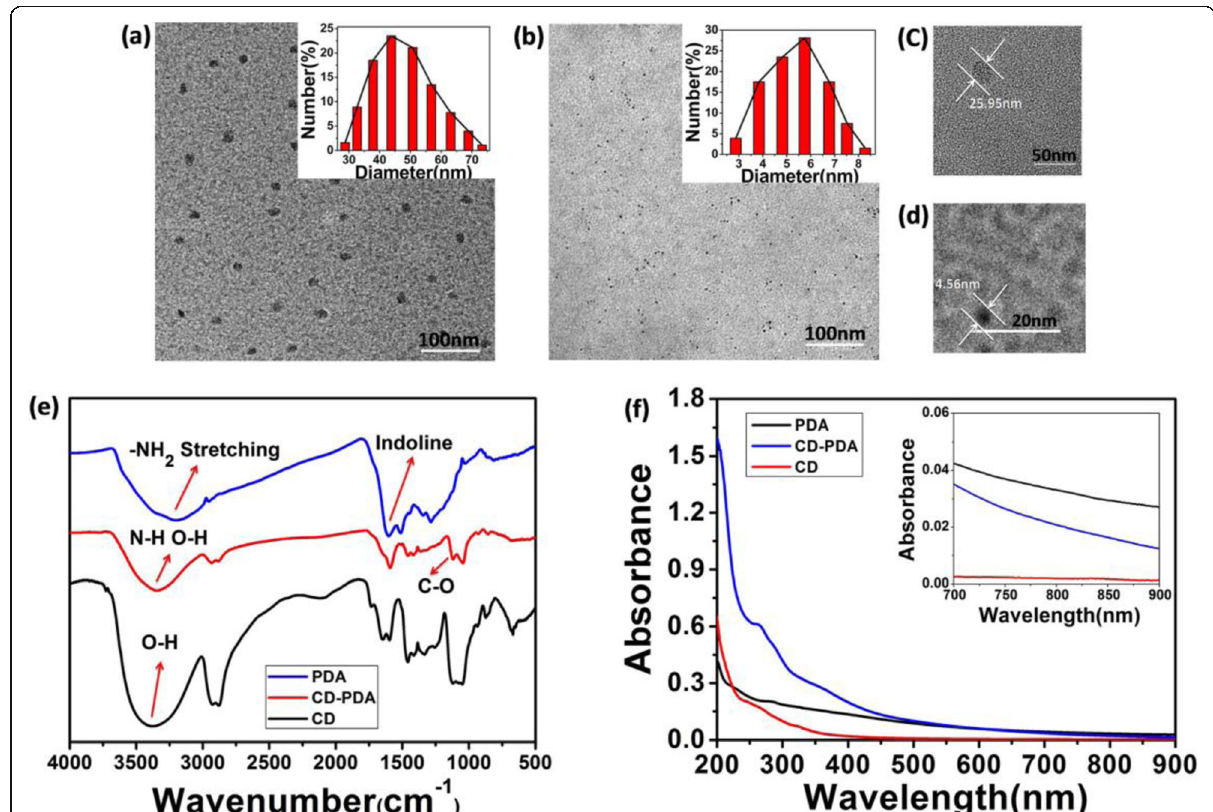
Fig. 1 Morphology, FT-IR spectra, and UV-Vis spectra of CD-PDA and CDs. a TEM image of CD-PDA (scale bar 100 nm, inset: size distribution determined by DLS). b TEM image of CDs (scale bar 100 nm, inset: size distribution determined by DLS). c Zoomed-in image of a single CD-PDA (scale bar 50 nm). d Zoomed-in image of a single CD (scale bar 20 nm). e FT-IR spectra of CD-PDA, CDs, and PDA. f UV-Vis spectra of CD-PDA, CDs, and PDA (inset: the absorbance from 600 to 900